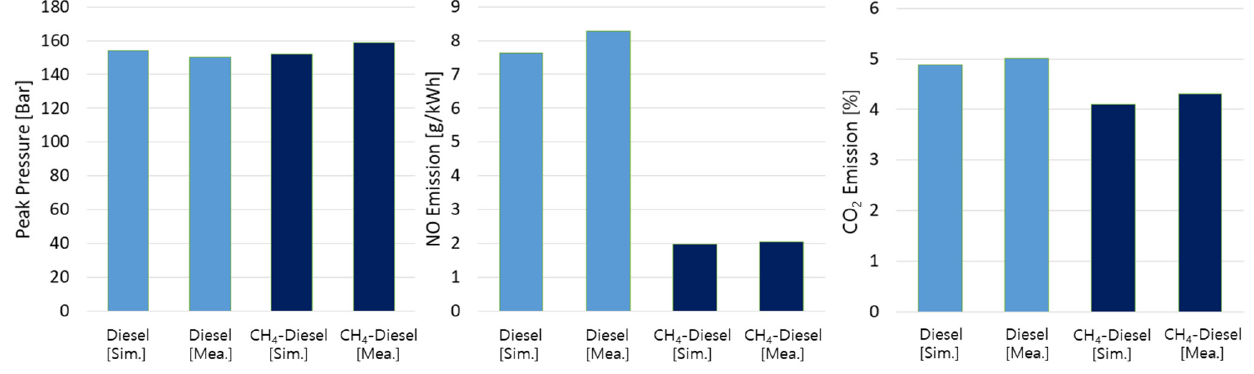
Figure 7. Comparisons of simulation results and shop test data Table 6. Engine specifications and shop test conditions and results Specifications